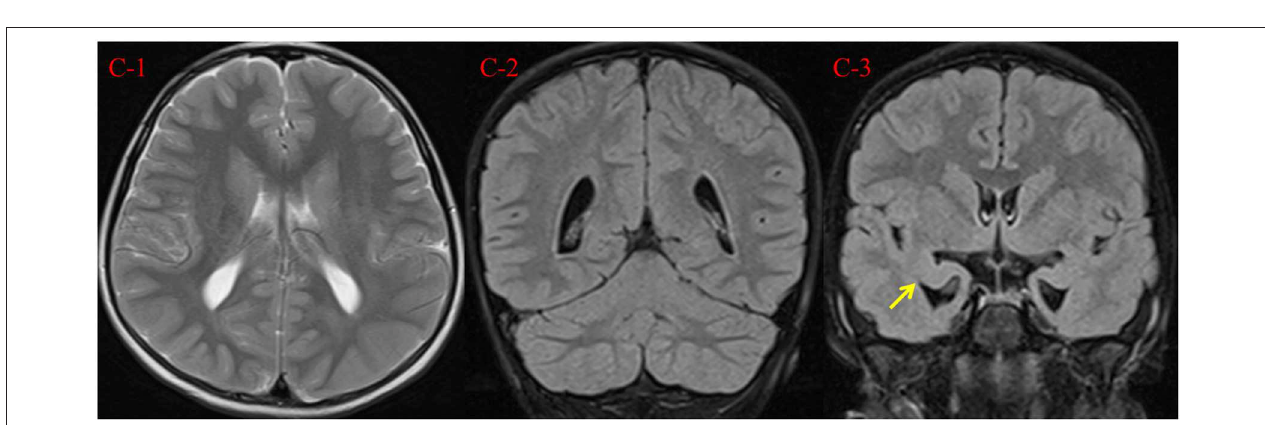
FIGURE 2 | Brain MRI findings at 7 years and 2 months. (C-1, C-2) Axial T2 weighted image and coronal T2 FLAIR demonstrate mild enlargement of the lateral ventricles. (C-3) Coronal T2 FLAIR demonstrates reduced volume of the bilateral hippocampus (arrow), with peculiar temporal horn